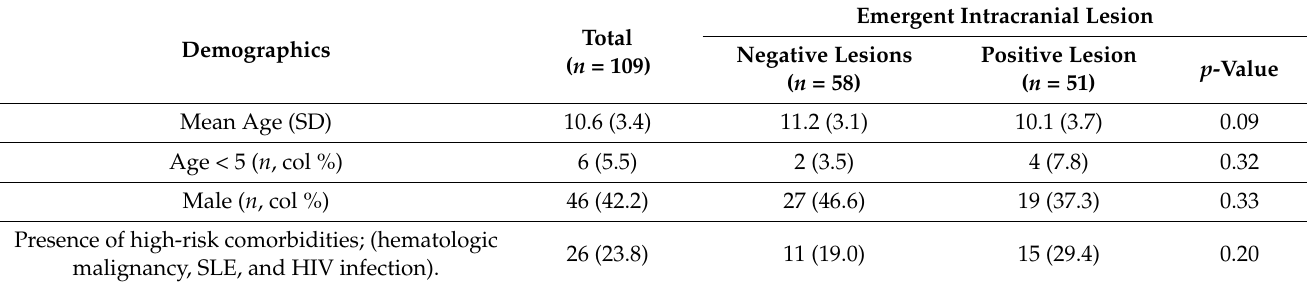
Table 1. Baseline demographics.